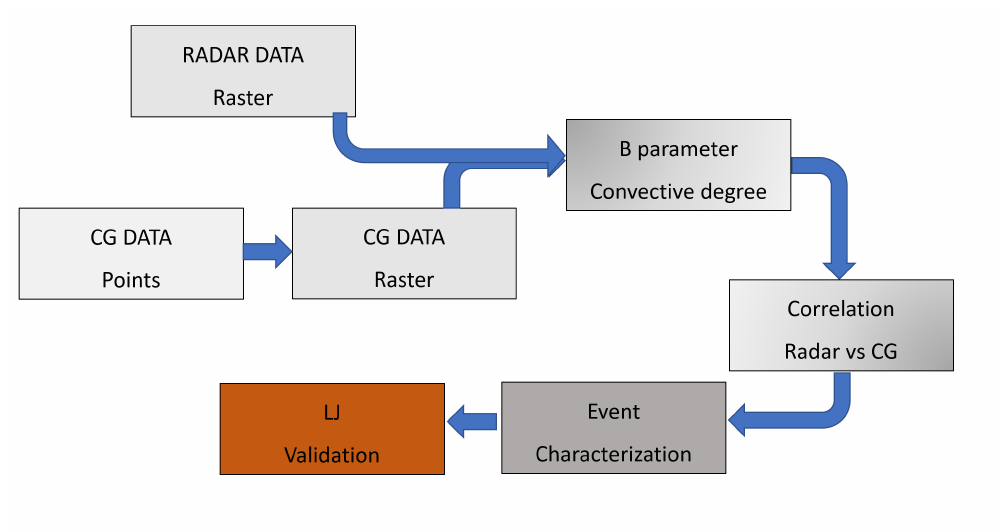
Figure 3. Scheme of the procedure considered in the